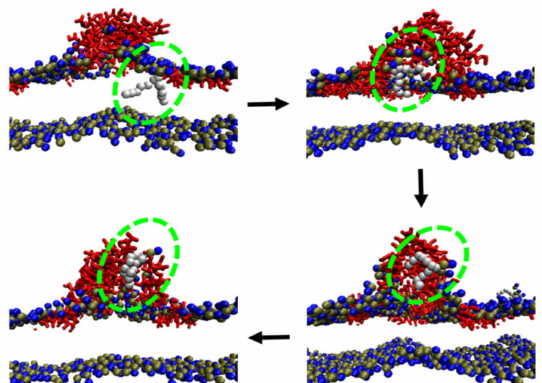
Figure 4. A typical structural disturbance to membrane by melittin: lipid extraction. The extraction process of a lipid (with tails in silver-grey and headgroup in blue and dark green) from a DOPC bilayer by melittin (red) is highlighted with a green dashed circle and indicated with black arrows. Lipid headgroups are displayed with blue and dark green spheres. Lipid tails are not shown for clarity. The figure is reprinted with permission from [85], copyright 2018